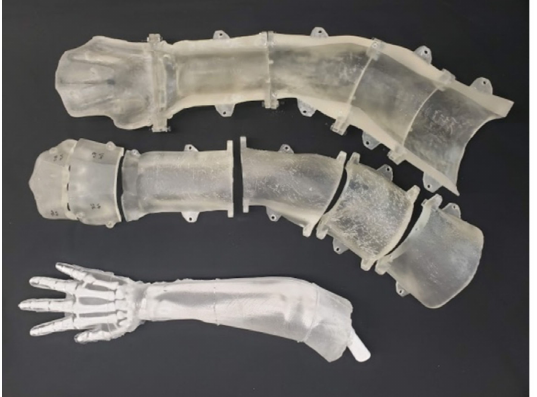
Figure 6. Photograph showing an unskinned phantom arm ( bottom ) beside its multi-piece casting mold ( top ) printed from FormLabs’ SLA